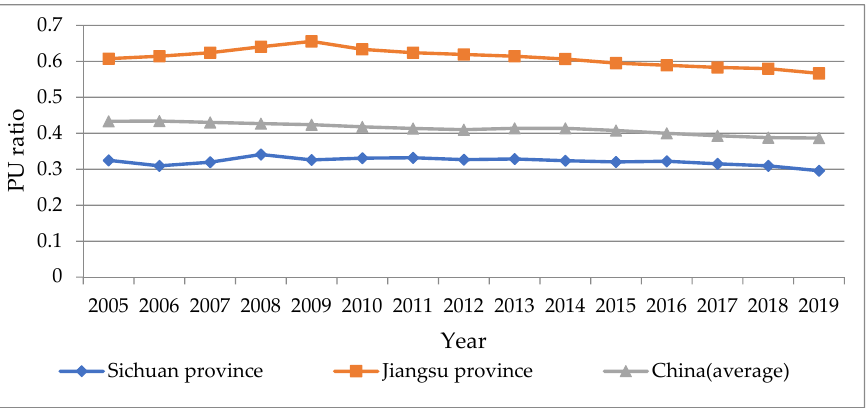
Figure 8. The calculation results and comparative analysis of PU ratio from 2005 to 2019 (data sources are Sichuan Statistical Yearbook 2020 , Jiangsu Statistical Yearbook 2020 , and China Statistical Yearbook 2020 ).